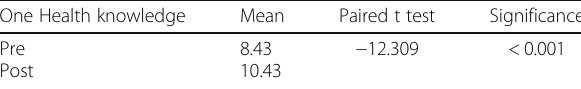
Table 1 Mean difference in One Health knowledge One Health knowledge